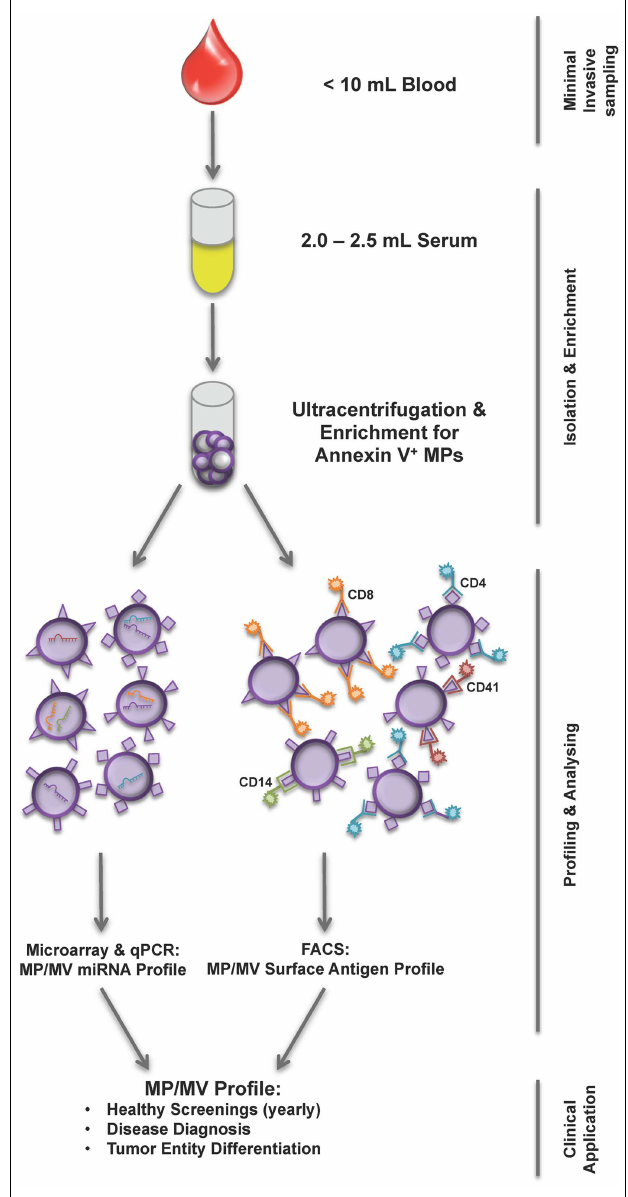
FIGURE 1 |Workflow of current MP/MV profiling strategies . From less than 10mL of blood sample first serum is prepared and subsequently MPs are isolated using ultracentrifugation and AnnexinV enrichment.The isolation is followed by either a miRNA analysis of MP/MV content or FACS phenotyping using various surface marker combinations determining the underlying disease.The MP/MV profile generated this way could help health screening, diagnosis, and tumor